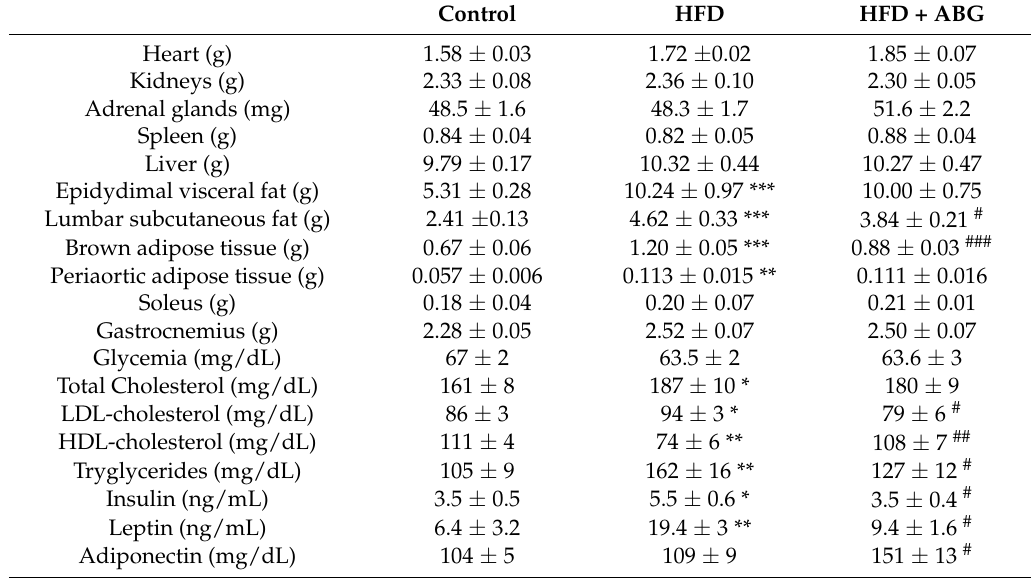
Data are represented as mean value ± SEM; n = 8–12 samples/group. * p < 0.05 vs. control; ** p < 0.01 vs. control; *** p < 0.001 vs. control; # p < 0.05 vs. HFD; ## p < 0.01 vs. HFD; ### p < 0.001 vs. HFD. Organ and tissue weights were compared after removing the influence of body weight by